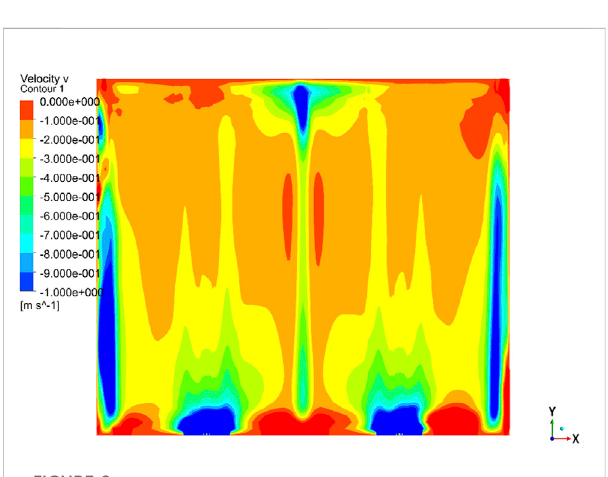
FIGURE 7 History of u y at sample Points 1, 2, and 3.